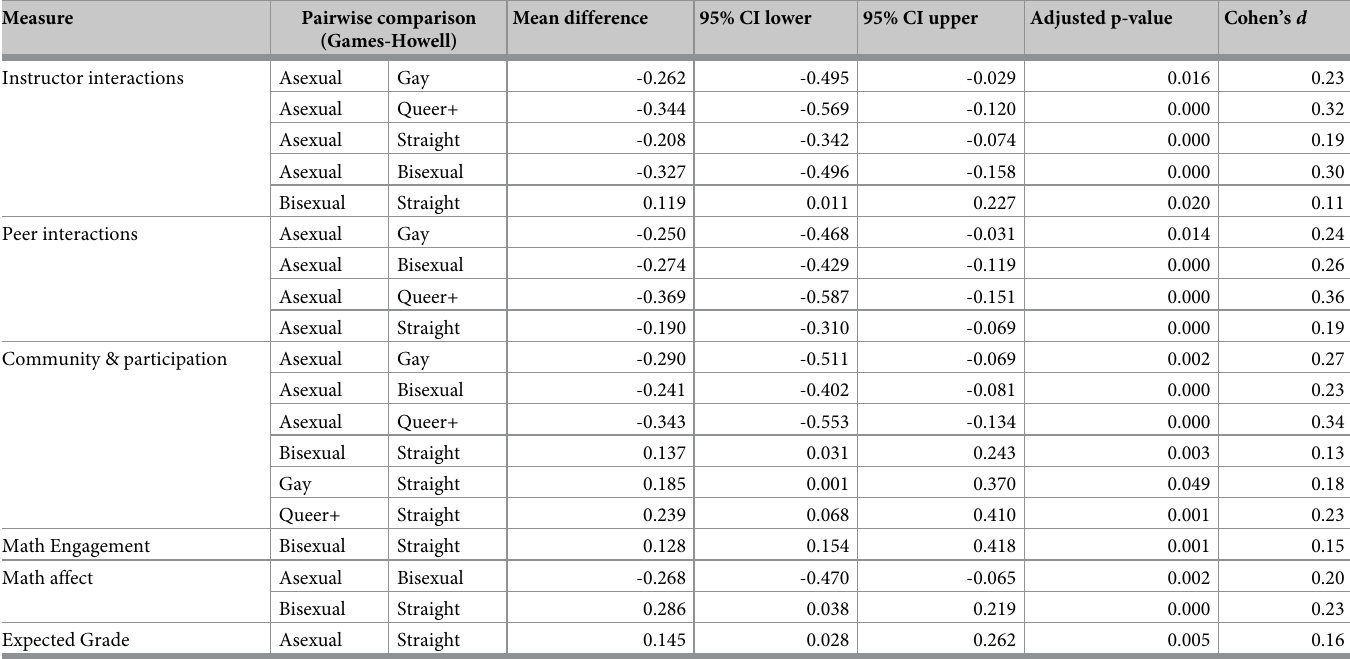
Table 6. Significant post hoc test of math instructional experiences and sexuality.